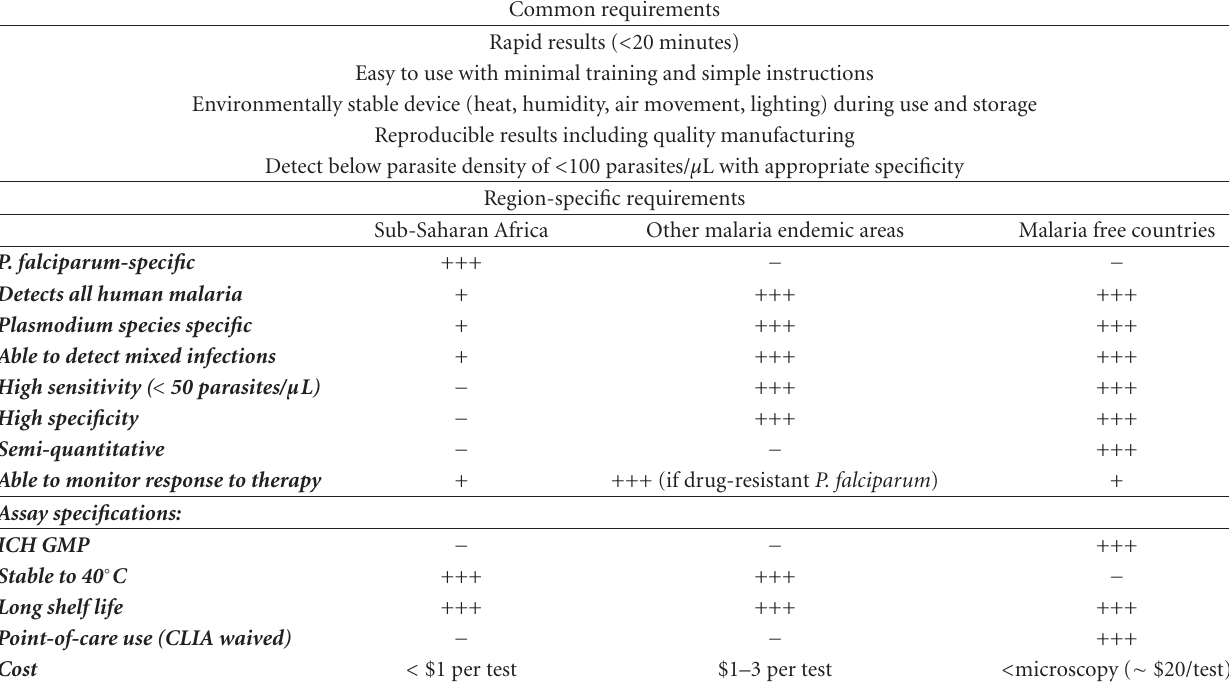
Table 1: Ideal requirements for a malaria rapid diagnostic test